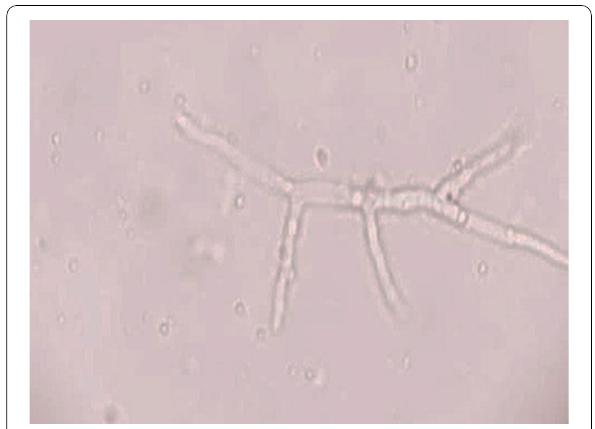
Fig. 2 High-power microscopy of a potassium hydroxide (KOH) mount demonstrates a broad, aseptate, branching (at